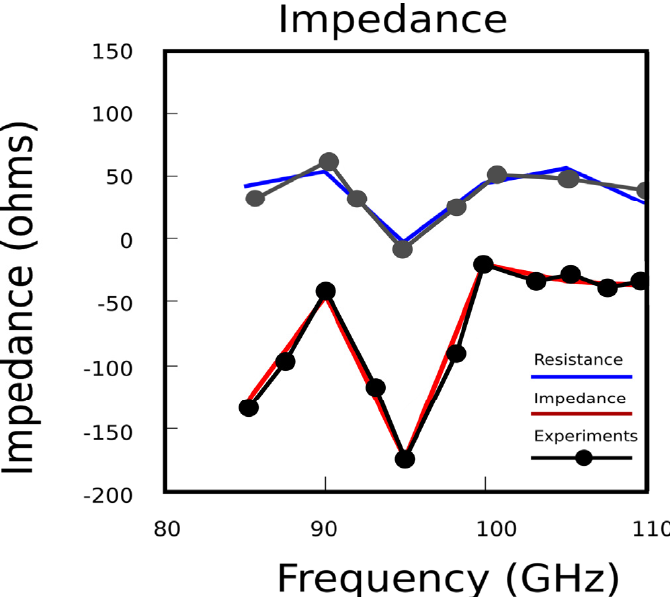
Figure 20. Graphical representation of simulated and measured impedance.